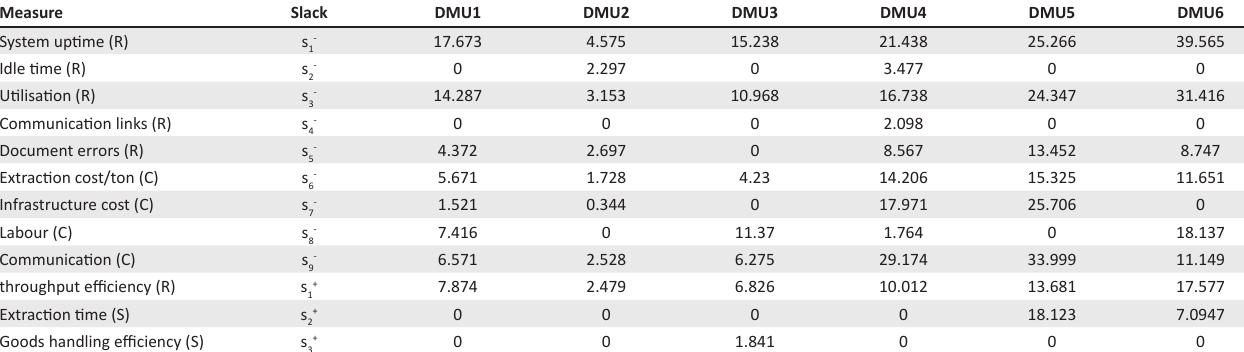
TABLE 4: Port node slacks analysis